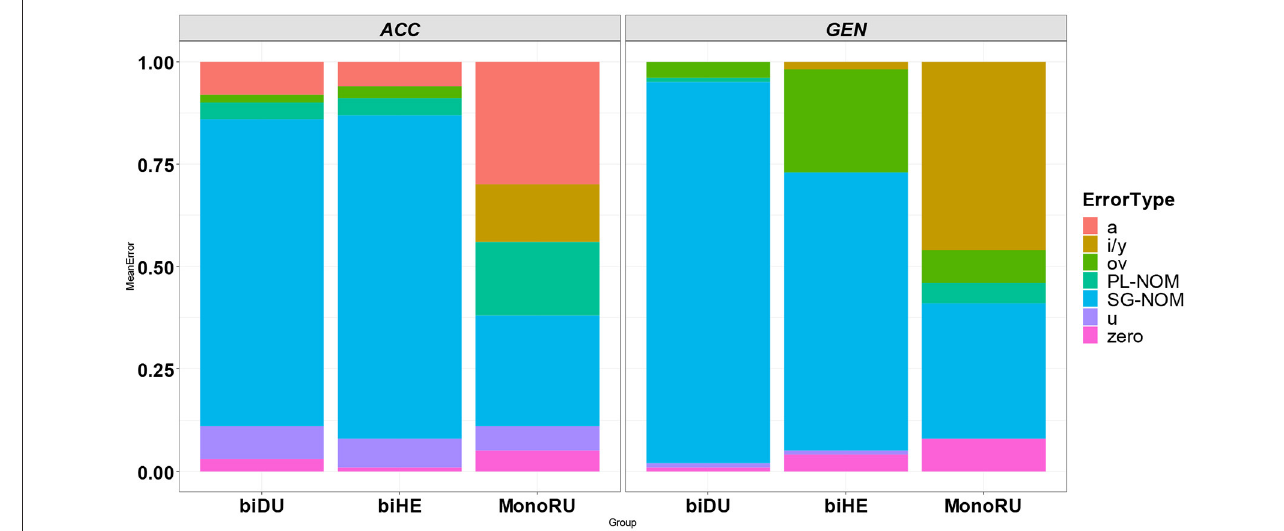
FIGURE 3 | Error pattern distributions per case per group.